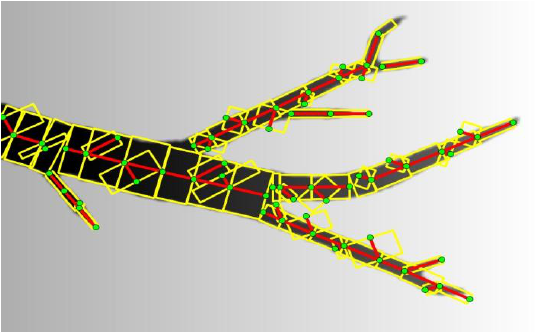
Figure 10. Results achieved by excluding the prior term for the flow direction ( p f = 0).